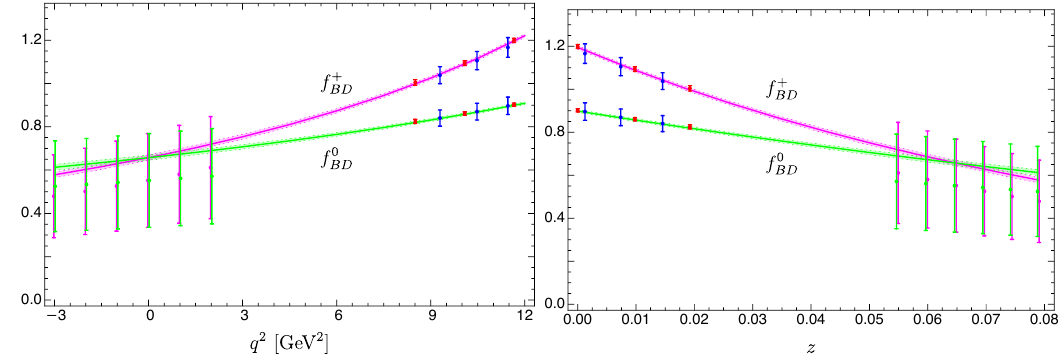
Figure 5 . BGL fitted results of the form factors as functions of q 2 (left) and z (right). The red (blue) points with error bars represent the FNAL/MILC (HPQCD) data whereas the magenta and green points are LCSR results from this work for f + ( q 2 ) and f 0 ( q 2 ) , respectively. The magenta BD BD (green) curves correspond to f + ( q 2 ) ( f 0 ( q 2 ) ) obtained by fitting the combined data of LCSR and BD BD lattice predictions. The shaded regions are error bands due to uncertainties of the three parameters in table